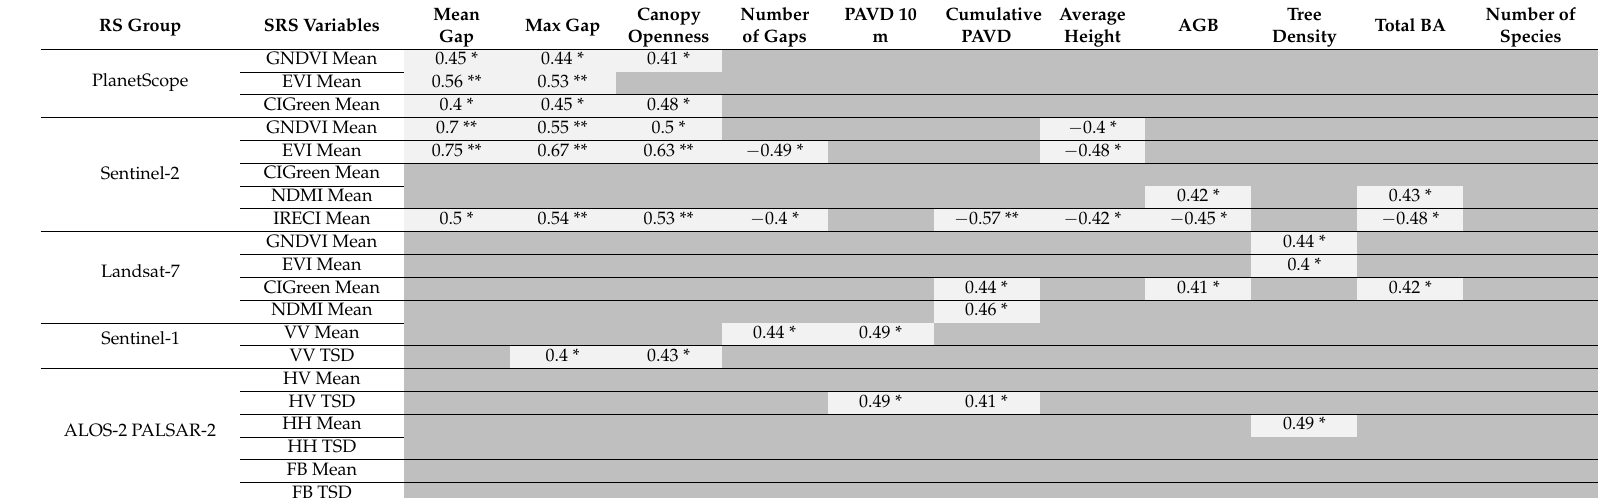
Table 4. Summary of the Pearson linear correlation r values between satellite remote sensing variables and field-measured structural parameters. ** = p < 0.01, * = p < 0.05, grey = p >